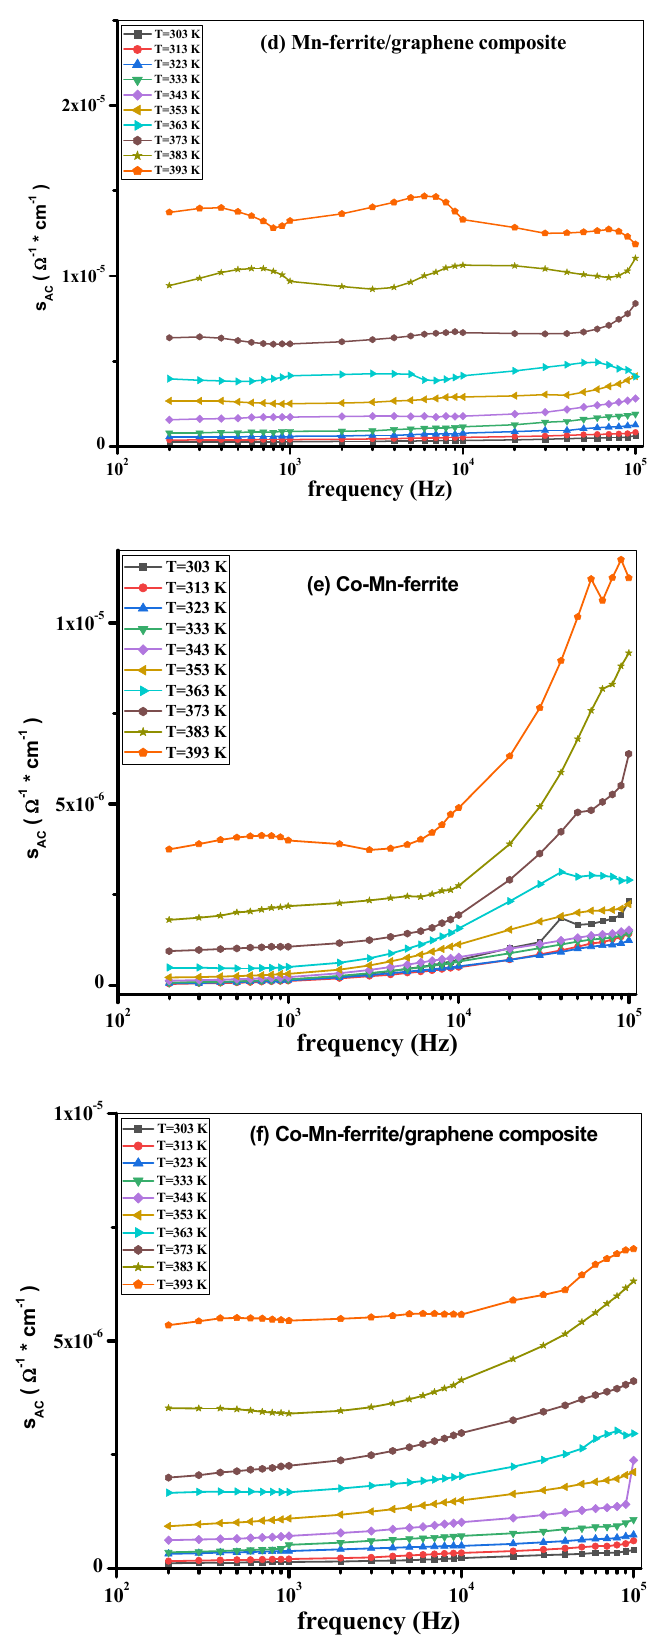
Figure 6. ( a ) σ AC vs. frequency at different temperatures of Co-ferrite, ( b ) Co-ferrite/graphene, ( c ) Mn-ferrite, ( d ) Mn-ferrite/graphene, ( e ) Co-Mn ferrite, and ( f ) Co-Mn ferrite/graphene samples.